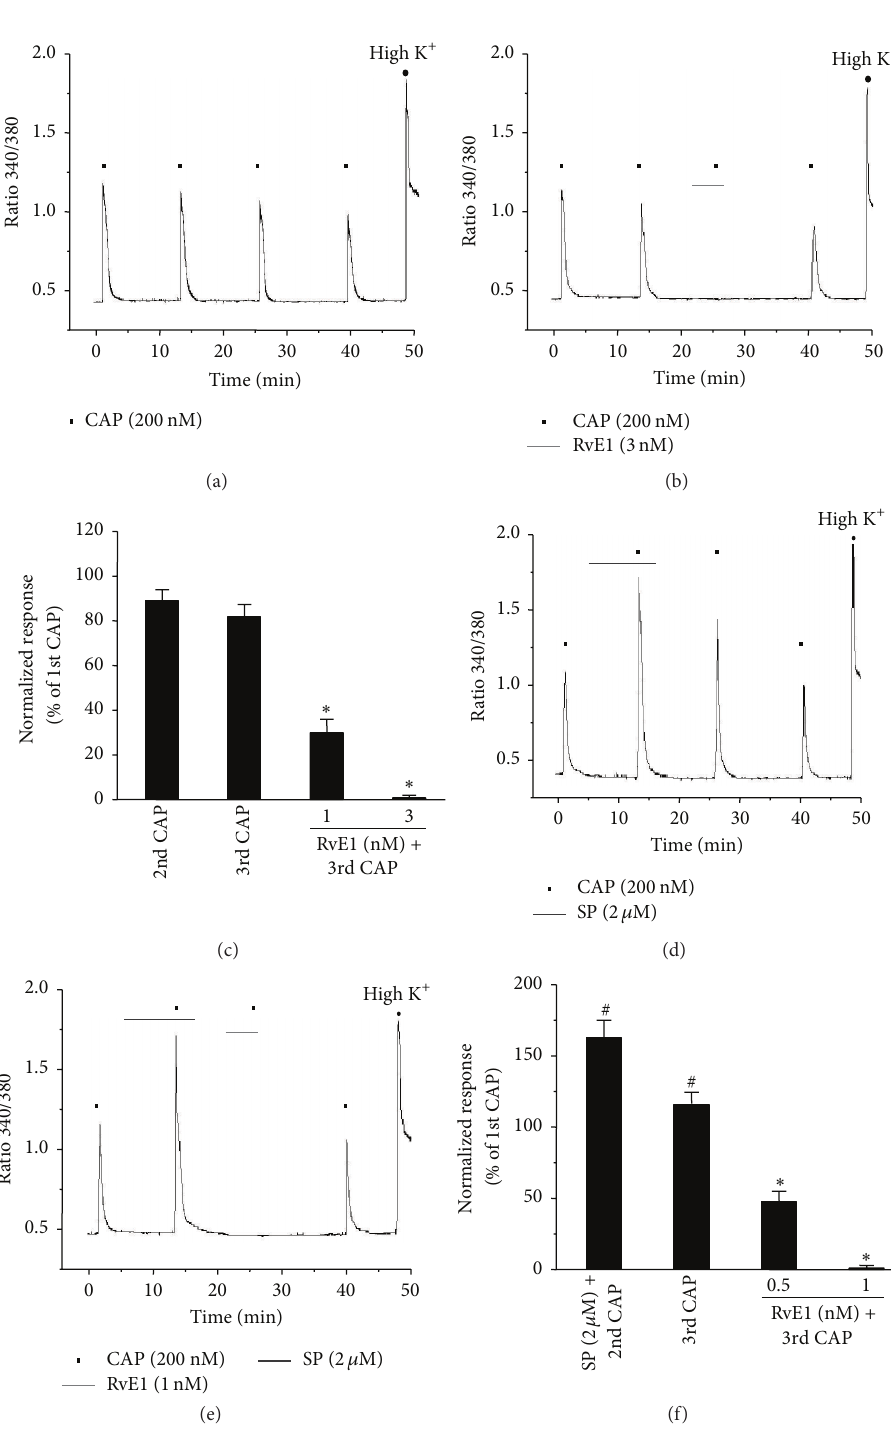
Figure 2: RvE1 inhibits substance P- (SP-) induced potentiation of capsaicin in nociceptive neurons. (a) Capsaicin (CAP, 200 nM) produced consistent [Ca 2+ ]i responses without desensitization after repetitive application (intervals of 8 ∼ 10min). Cell viability of neurons was confirmed by their response to high K + (50 mM KCl solution) at the end of the experiment. 𝑛 = 18 . (b) RvE1 (3nM) completely inhibited capsaicin-induced [Ca 2+ ]i in capsaicin-responsive neurons. Neurons were perfused with RvE1 (3nM) for 5 min before the third application of capsaicin. 𝑛 = 35 . (c) Summary of [Ca 2+ ]i responses relative to peak amplitude of first capsaicin responses. Note that RvE1 (1nM) inhibits 70% of capsaicin-induced [Ca 2+ ]i. Results are presented as the mean ± SEM. ∗ 𝑃 < 0.05 ; 𝑡 -test versus second capsaicin treatment. (d) Substance P (2 𝜇 M) enhanced capsaicin- (200nM) induced [Ca 2+ ]i in small dorsal root ganglion (DRG) neurons ( 𝑛 = 29 /40). Neurons were perfused with substance P (2 𝜇 M) for 10min before the second application of capsaicin. (e) RvE1 (1nM, 5min) completely inhibited substance P-induced potentiation of capsaicin in small DRG neurons. 𝑛 = 20 (f) Summary of [Ca 2+ ]i responses relative to peak amplitude of first capsaicin responses. Note that RvE1 (0.5nM) inhibits 45% of substance P-induced potentiation of capsaicin. Results are presented as the mean ± SEM. ∗ 𝑃 < 0.05 ; 𝑡 -test versus second capsaicin treatment. # 𝑃 < 0.05 ; 𝑡 -test versus first capsaicin